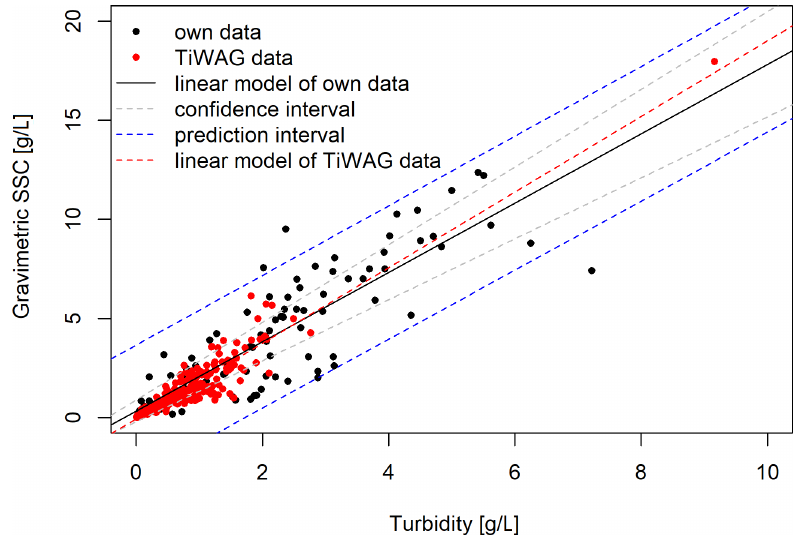
Figure 2. Gravimetric suspended sediment concentrations SSC g in samples vs. turbidity measured at the gauge in Sölden: TiWAG samples taken between 2012 and 2017 are all located within the prediction interval of the linear regression based on our samples, and the linear model based on TiWAG data is located within the confidence